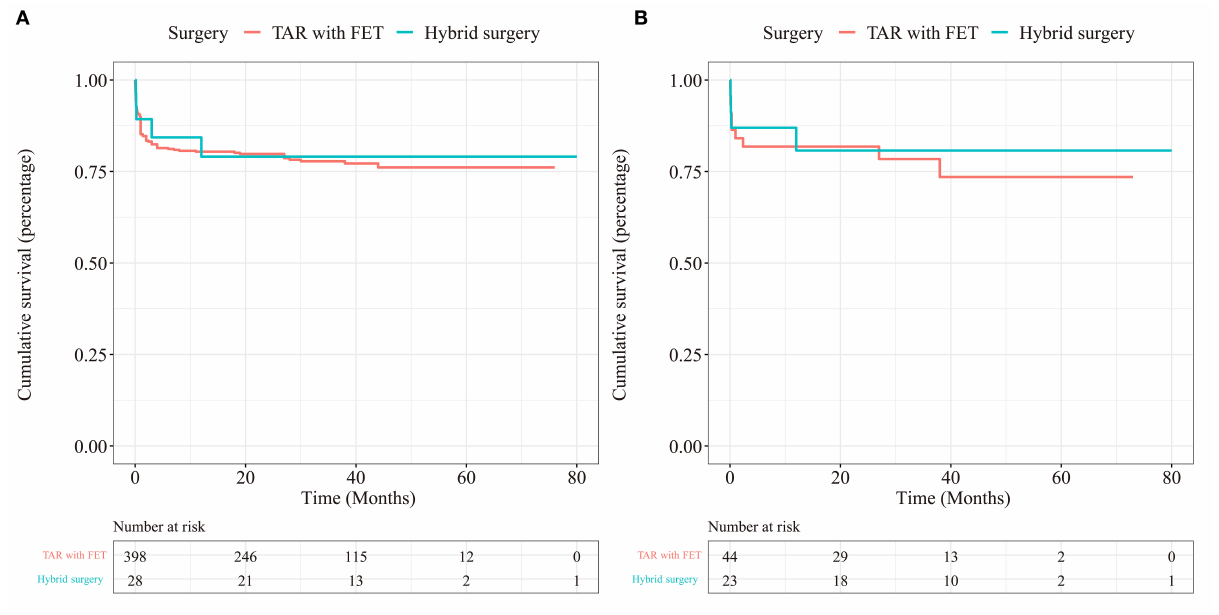
aorta repair, hybrid surgery can still shorten the aortic cross-clamp time to reduce myocardial ischemia, and it also